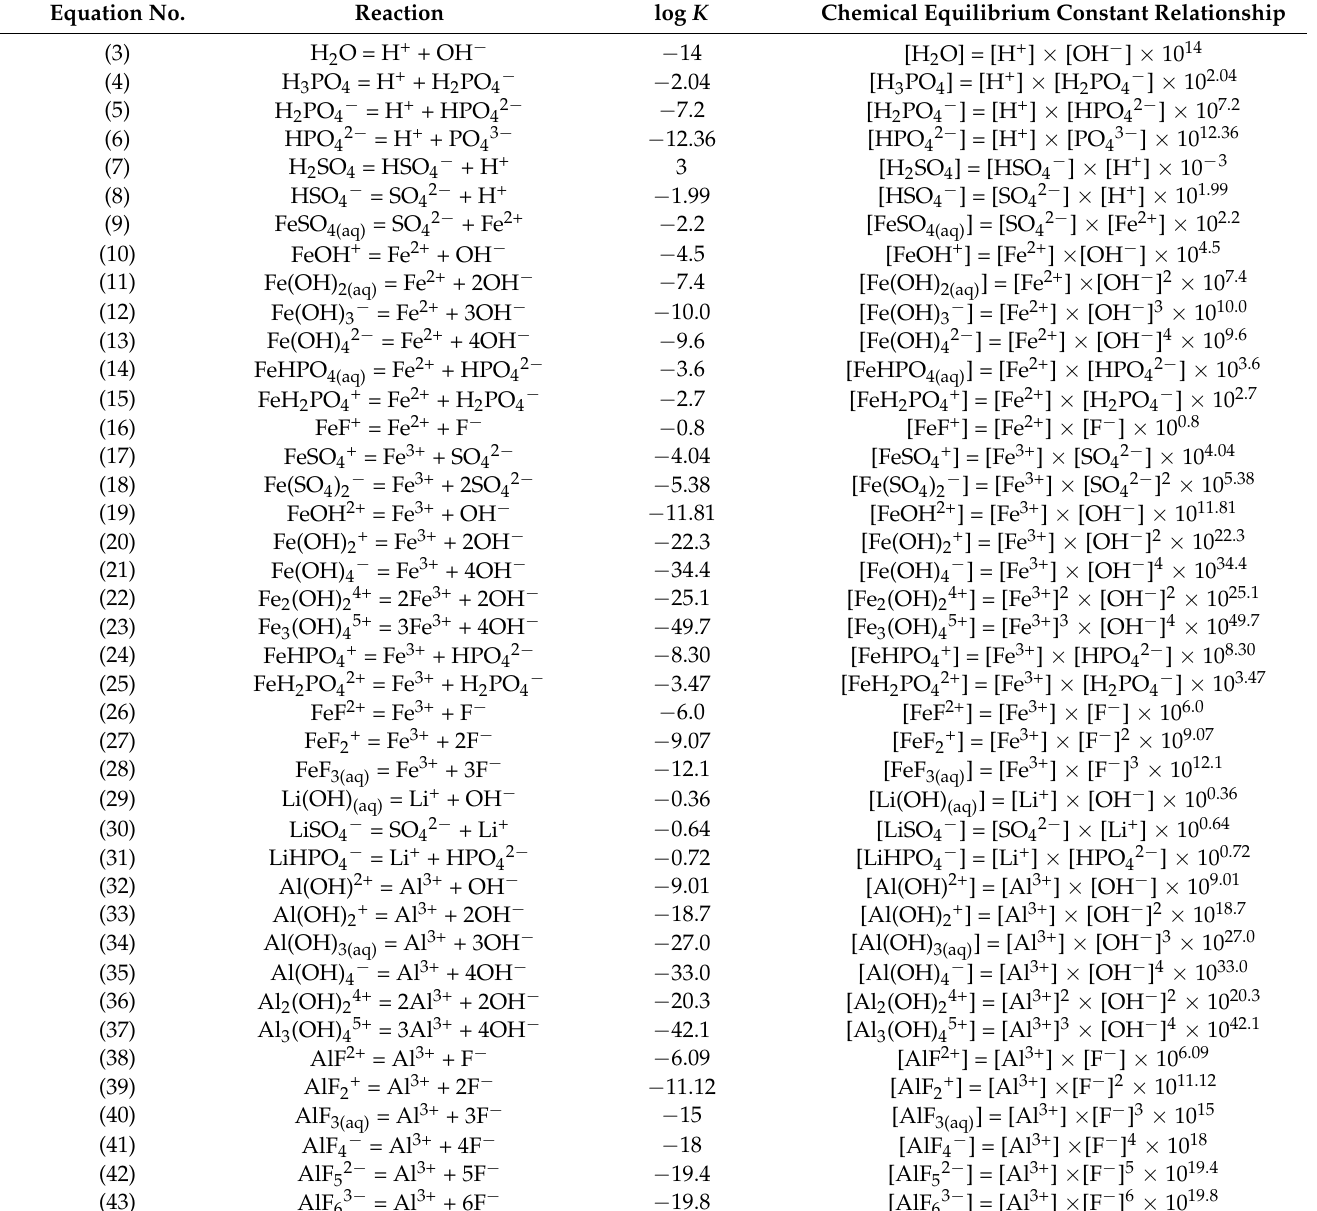
Table 3. Thermodynamic equilibrium equations and their equilibrium constants in the Li + –Fe 2+ /Fe 3+ –Al 3+ –PO 43 − –SO 42 − – F − –H 2 O system (298 K)